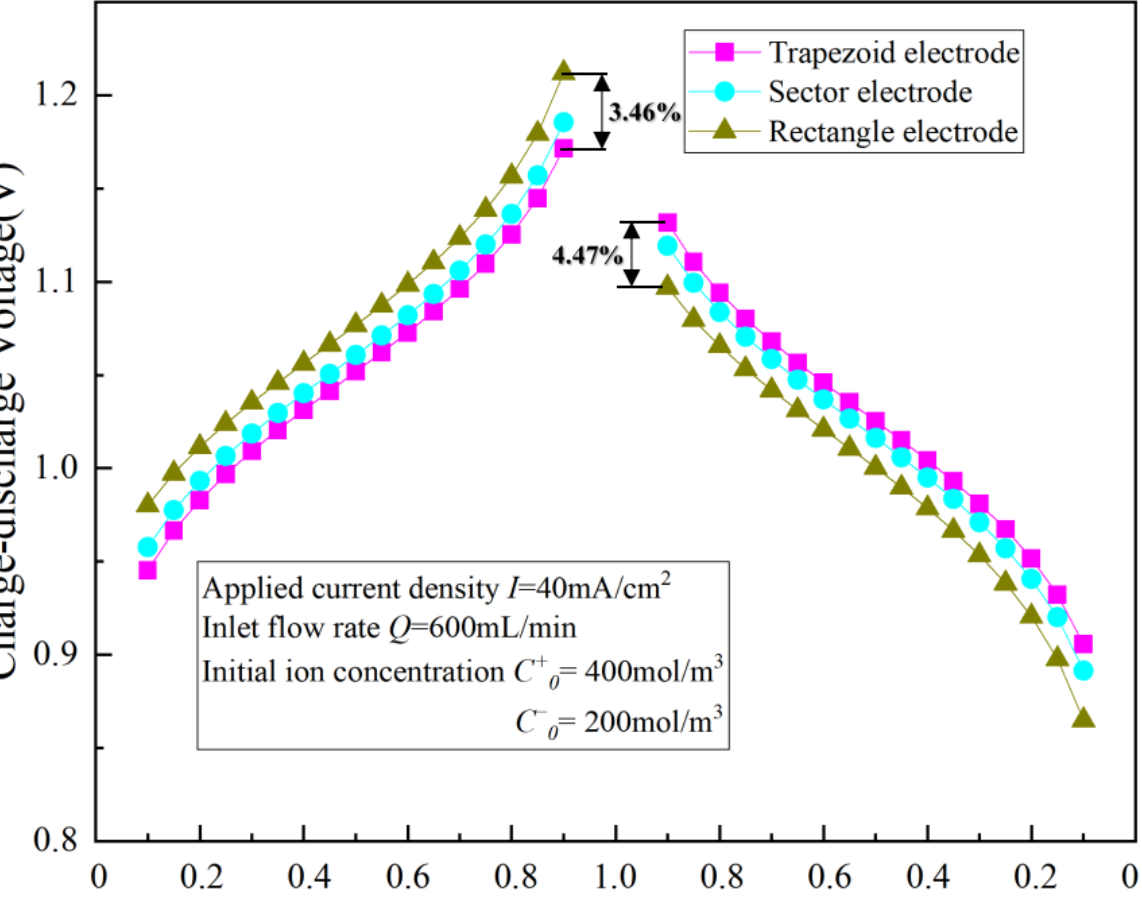
Figure 3. Variations in the charge-discharge voltages for the ferrocyanide-based ORFBs with different